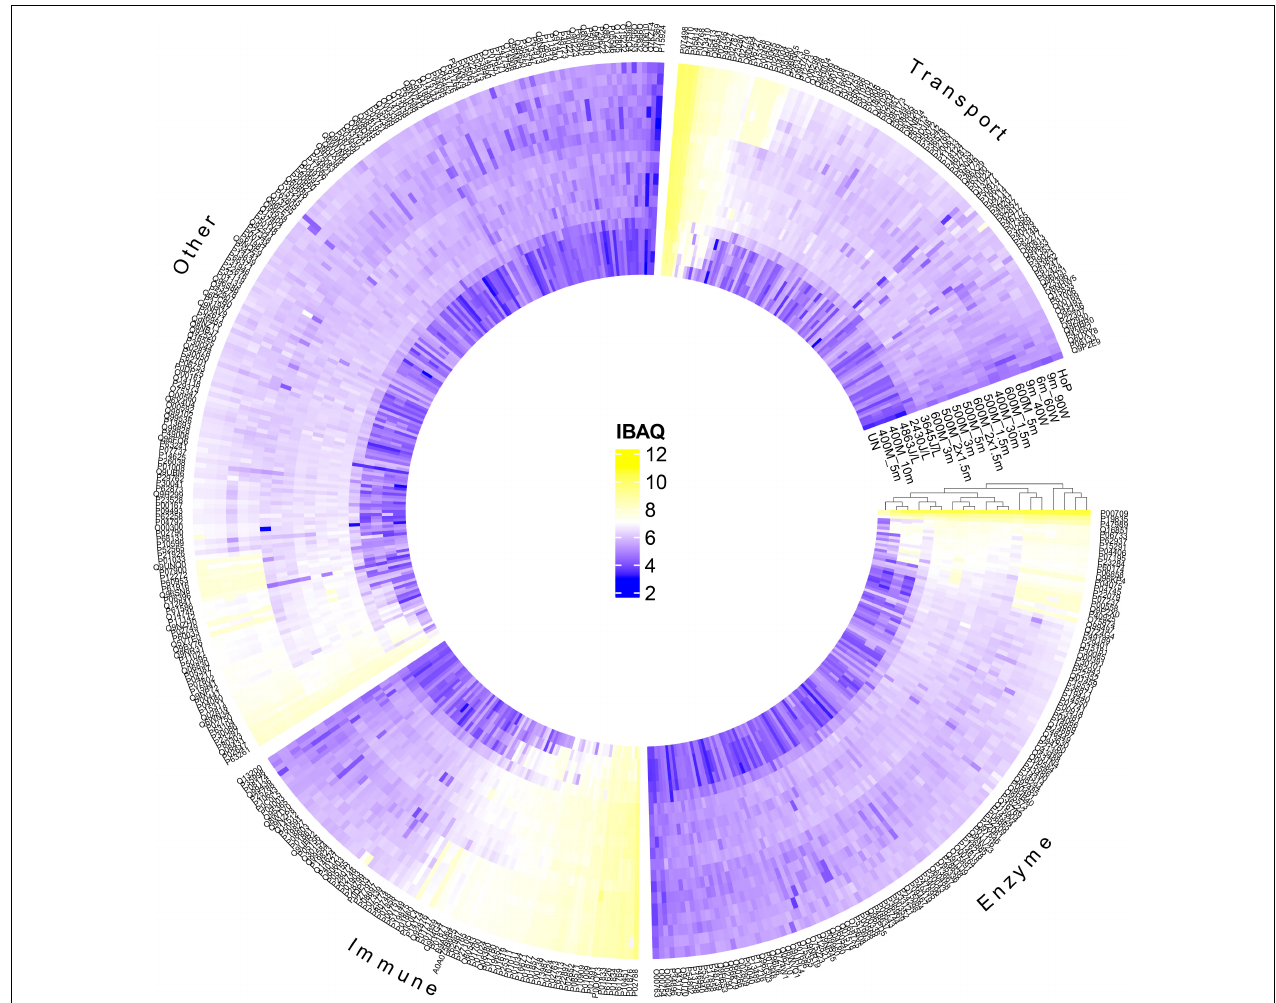
FIGURE 3 | Hierarchical cluster analysis and heatmap showing the changes in the protein profile after HPP, UV-C, TUS, and HoP, based on iBAQ values (log 10 scale from 2 to 12 according to color bar). Proteins are labeled by their UniProt ID. Functional categories (enzyme, immune, transport, and other) were based on GO annotation of biological function. Two independent experiments (biological replicates) were performed while all analyses were performed in technical duplicate for each sample. UN represents the untreated values. HPP; 400 MPa for 5, 10, and 30 min, 500 MPa for 1.5, 2 × 1.5, 3, and 5 min, 600 MPa for 1.5, 2 × 1.5, 3, and 5 min, UV-C; 2430J/L, 3645J/L, and 4863L/L,TUS; 9_40W, 6_60W, and